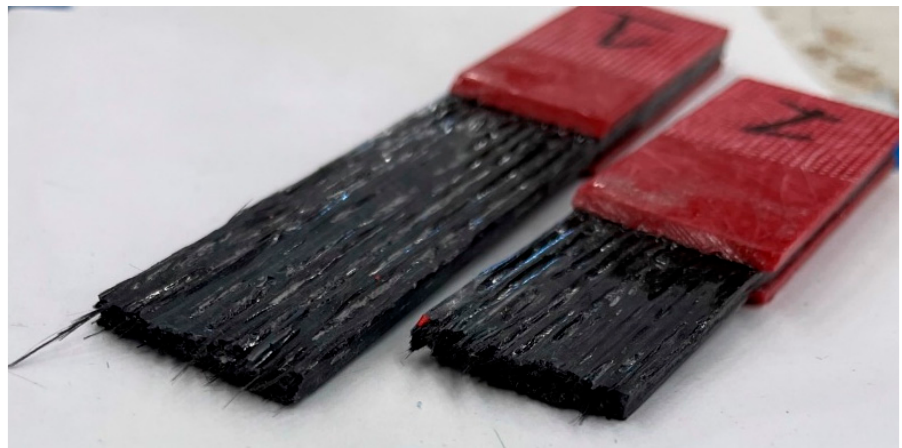
Figure 6. Tensile specimen failure section.